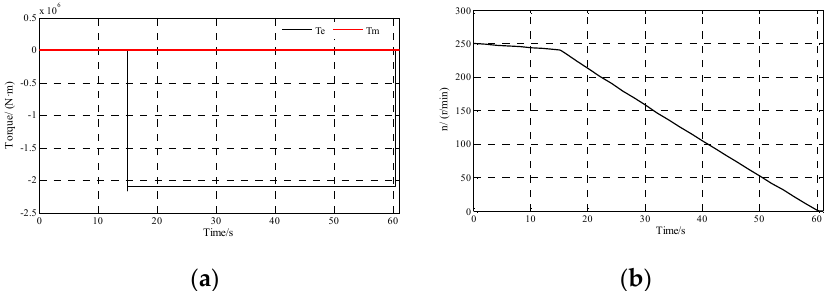
Figure 12. Waveform of shutdown stage in generating mode. ( a ) T m and T e ; ( b ) speed.